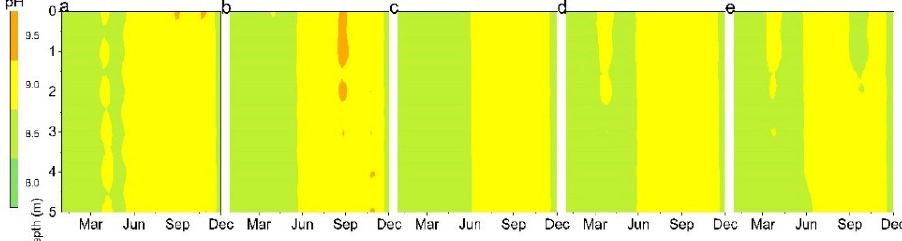
Figure 4. Spatiotemporal variation in pH in Lake Xingyun, measured during 2017. ( a ) XYH ‐ 1. ( b ) XYH ‐ 2. ( c ) XYH ‐ 3. ( d ) XYH ‐ 4. ( e ) XYH ‐ 5. ( b ) XYH-2. ( c ) XYH-3. ( d ) XYH-4. ( e )